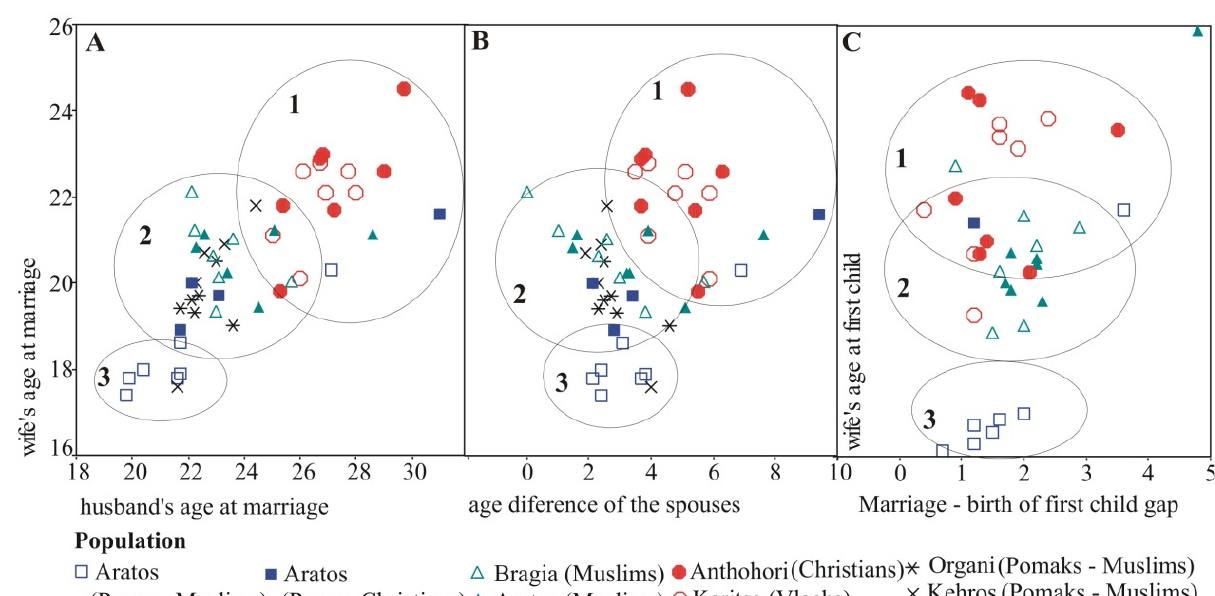
Figure 1. Scatterplot depicting 3 categories: the age of the spouses at marriage ( A ), age difference of the spouses ( B ) and age of mother at the birth of first child and chronological distance between this birth and marriage ( C ). Circles and numbers represent the population groups: 1 for Christians, 2 for Muslims and 3 for Roma. Example: A1: Marriage cohorts in Christian populations in Anthohori (red colored circles), Karitsa (red circles) and Aratos (blue colored squares)/A2: Marriage cohorts in Muslim populations in Bragia (green triangles), Aratos (green colored triangles), Organi (asterisk) and Kehros (x symbol)/A3: Marriage cohorts in Roma populations in Aratos (blue squares).